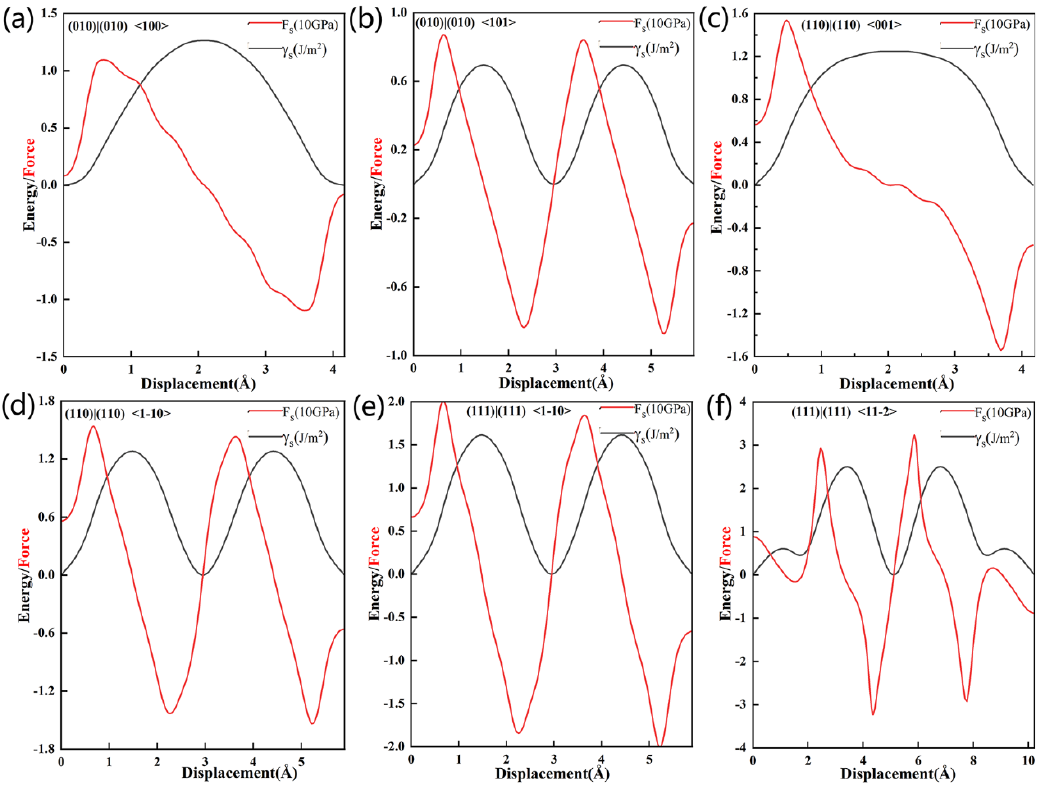
Figure 13. Stacking fault energy and maximum shear stress of interfacial systems slipping in different directions. Table 7. Maximum generalized unstable stacking fault energy, shear stress and corresponding Rice ratio ( D R ) and stress ratio for Al 3 Y(001)|Al(001), Al 3 Y(110)|Al(110), and Al 3